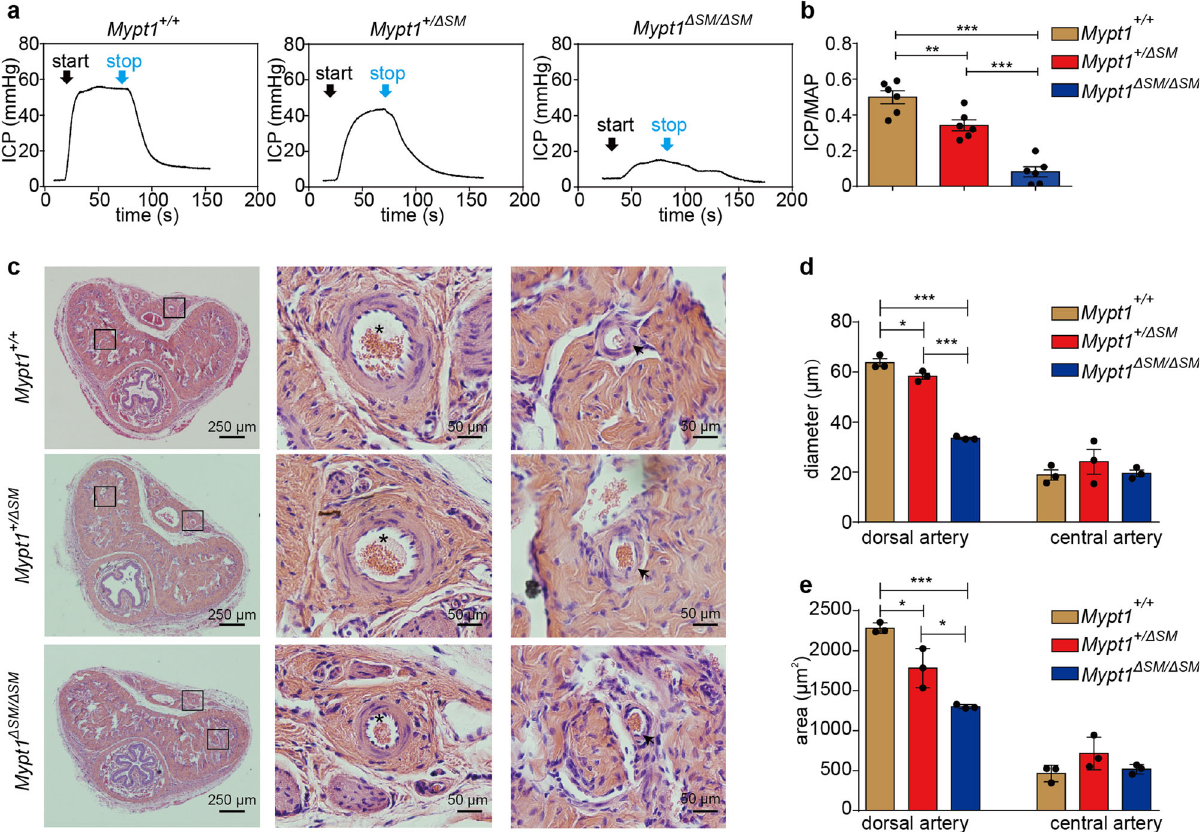
Fig. 1 MYPT1-de fi cient penises showed a reduced ICP response to EFS and reduced arterial sizes. a Representative ICP tracings after stimulation of Mypt1 + / + , Mypt1 + / Δ SM , and Mypt1 Δ SM/ Δ SM penises with 5 V/12 Hz for 1 min. b Quanti fi cation of the ICP/MAP values of the three groups ( n = 6). c – e , H-E staining showed a decreased diameter and area of penile arteries. Quantitation of the diameter ( d ) and the area ( e ) of dorsal and central arteries ( n = 3). “ asterisk ” represents dorsal artery; “ arrow ” represents helicine arteriole. The bars indicate the mean values ± SEMs; * p < 0.05, *** p < 0.001; One-way ANOVA . Table 3 Summary of sperm parameters of different genotyping mice ( n =